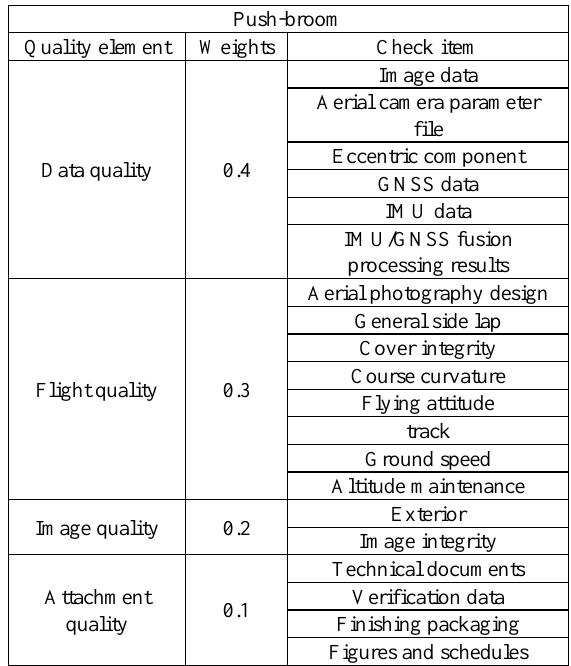
Table 1 . Quality elements and rights of digital aerial photography results(Frame type)